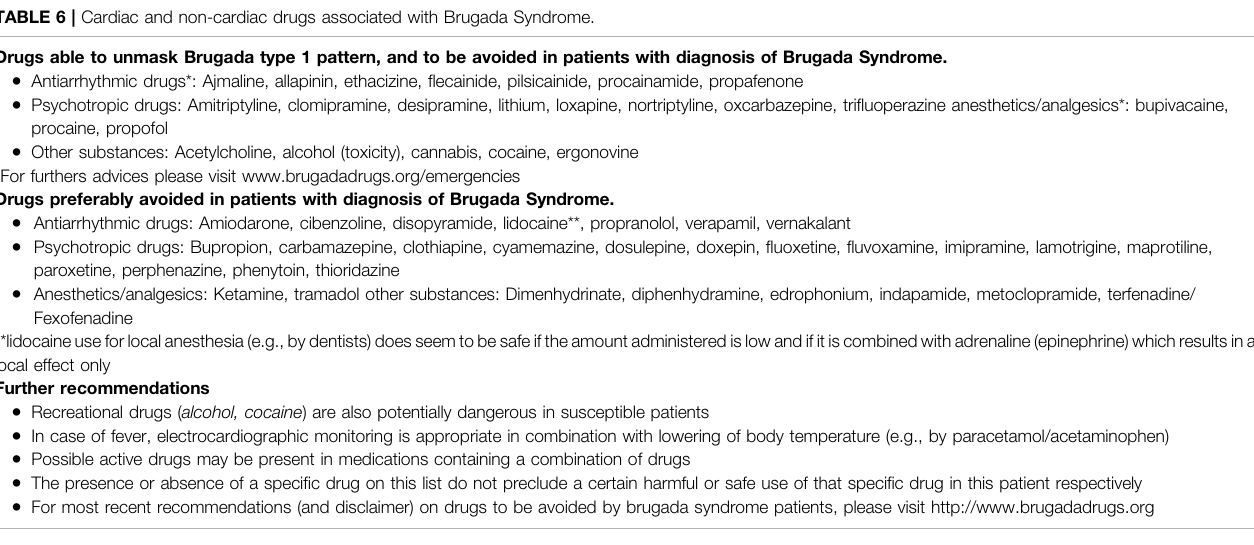
TABLE 6 | Cardiac and non-cardiac drugs associated with Brugada